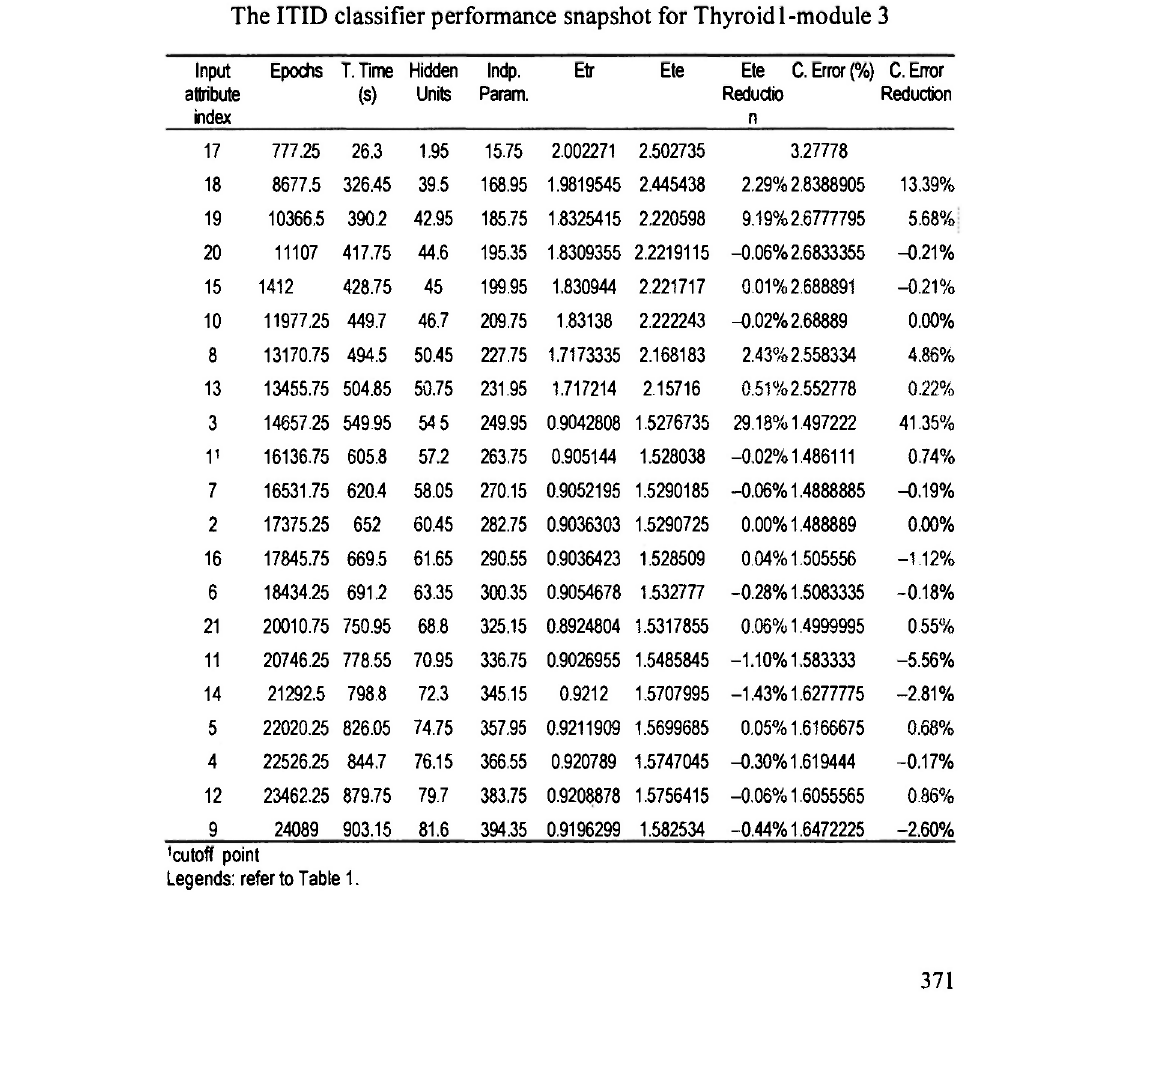
'cutoff point Legends: refer to Table